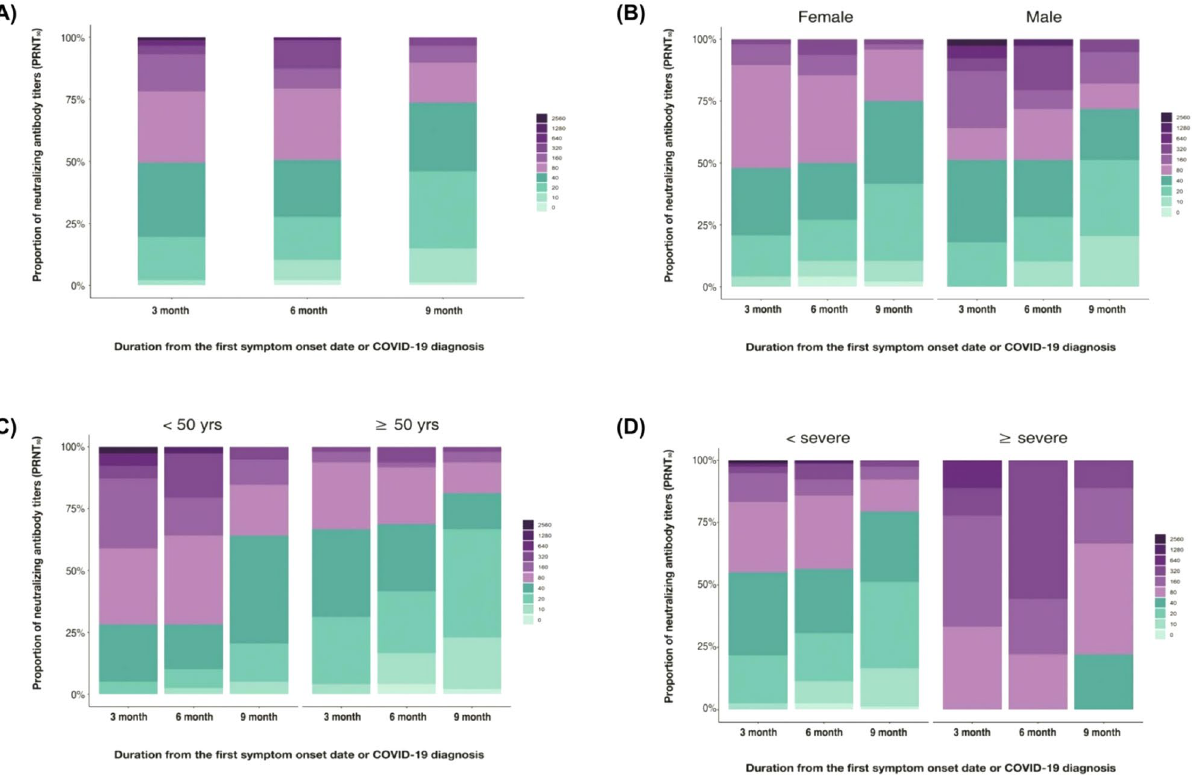
Figure 2. Distribution of SARS-CoV-2 neutralizing antibody (nAb) titers based on sex, age, and disease severity at intervals of 3 months. ( a ) The proportion of individuals with antibody titers ranging from − 2560 over the time points of 3, 6, and 9 months from the first COVID-19 symptom onset or diagnosis. ( b ) The proportion of individuals with antibody titers according to sex at the time points of 3, 6, and 9 months from the first COVID-19 symptom onset or diagnosis. ( c ) The proportion of individuals with antibody titers according to age < 50 or ≥ 50 years at the time points of 3, 6, and 9 months from the first COVID-19 symptom onset or diagnosis. ( d ) The proportion of individuals with antibody titers according to disease severity of < severe or ≥ severe at the time points of 3, 6, and 9 months from the first COVID-19 symptom onset or